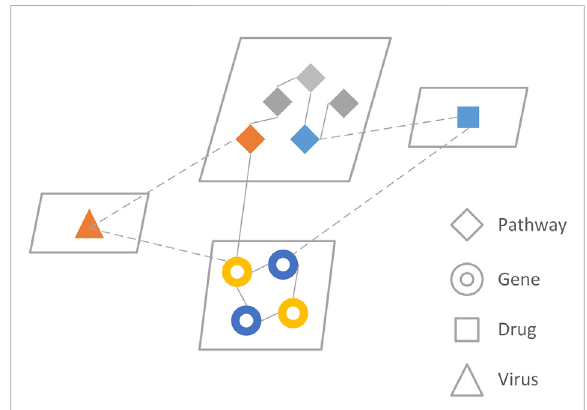
FIGURE 1 The network model of PINet. PINet model consists of four entities and seven relationships. The genes and pathways were directly related to RWR, and the drugs and viruses were integrated with the RWR algorithm through indirect